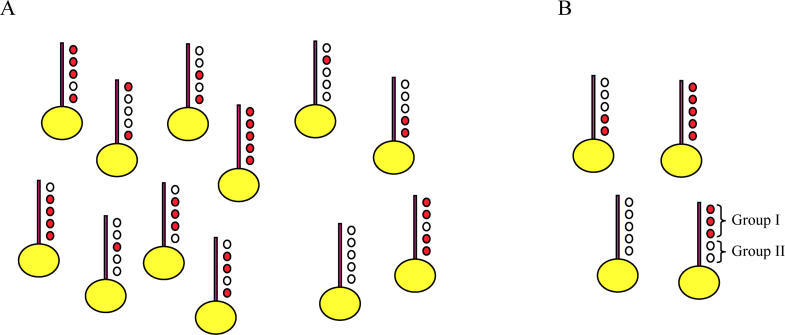
Histones can undergo many potential modifications, and it has been hypothesized that these can occur in many different combinatorial histone modification patterns (A). In this study, researchers found that only a few modification patterns occur in yeast, with many of the modifications co-occurring in groups (B)